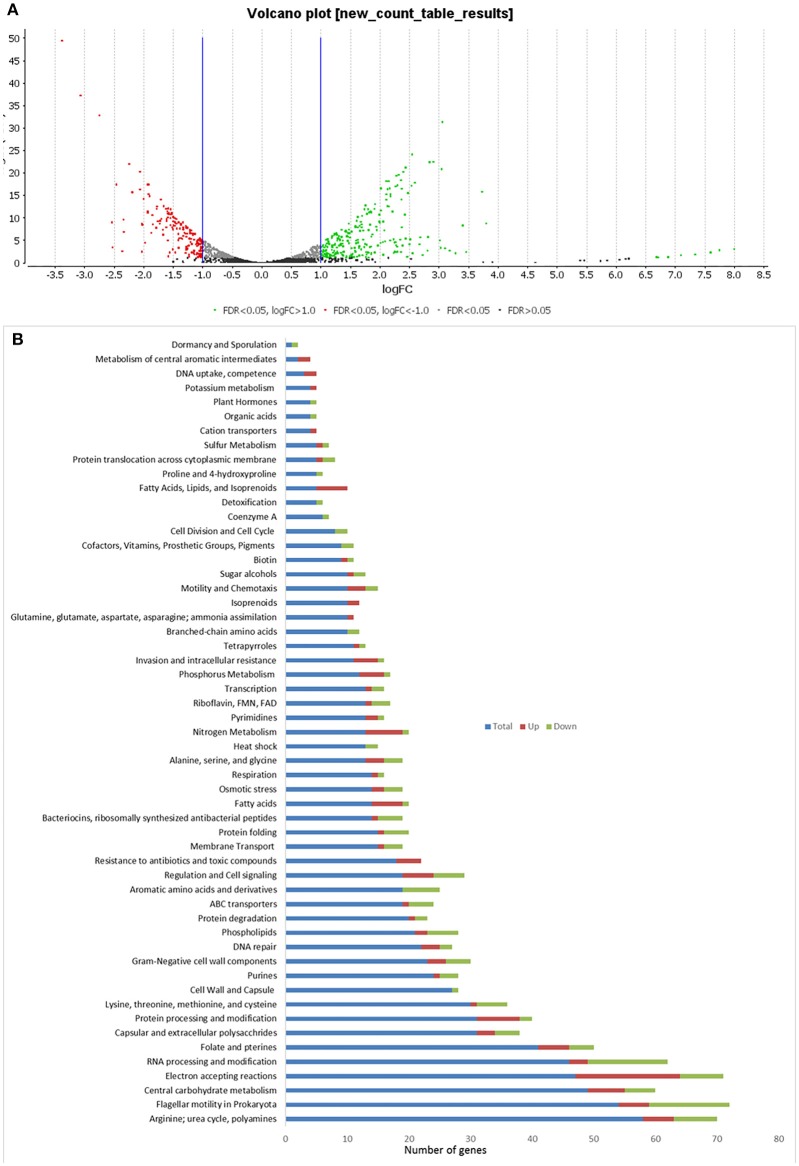
Comparison of differentially expressed genes identified between in vitro and in vivo conditions. (A) Volcano plots analysis of differentially expressed genes DEGs. The green dots represent DEGs up regulated in bile samples, the red dots represent DEGs down-regulated in bile samples, and the black/gray dots represent no DEGs. (B) Sub-categories of DEGs were as defined by the SEED viewer from the RAST annotations. Total: number of CDSs assigned to each subcategory, Up: DEGs up regulated while C. hepaticus in bile samples compared to in vitro samples.